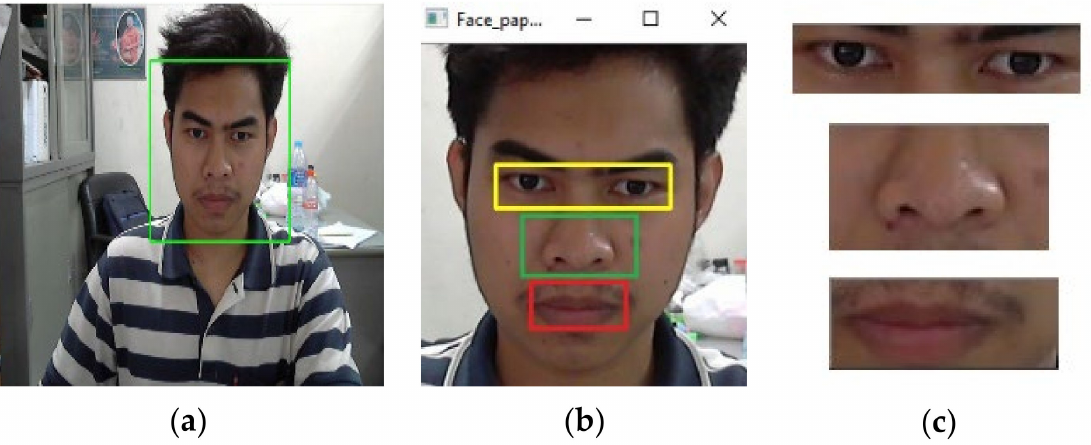
Figure 3. Defined ROI of facial components by the Haar cascade algorithm: ( a ) face detection; ( b ) eye, mouth, nose and detection; ( c ) extracted ROI of eye, nose and mouth.